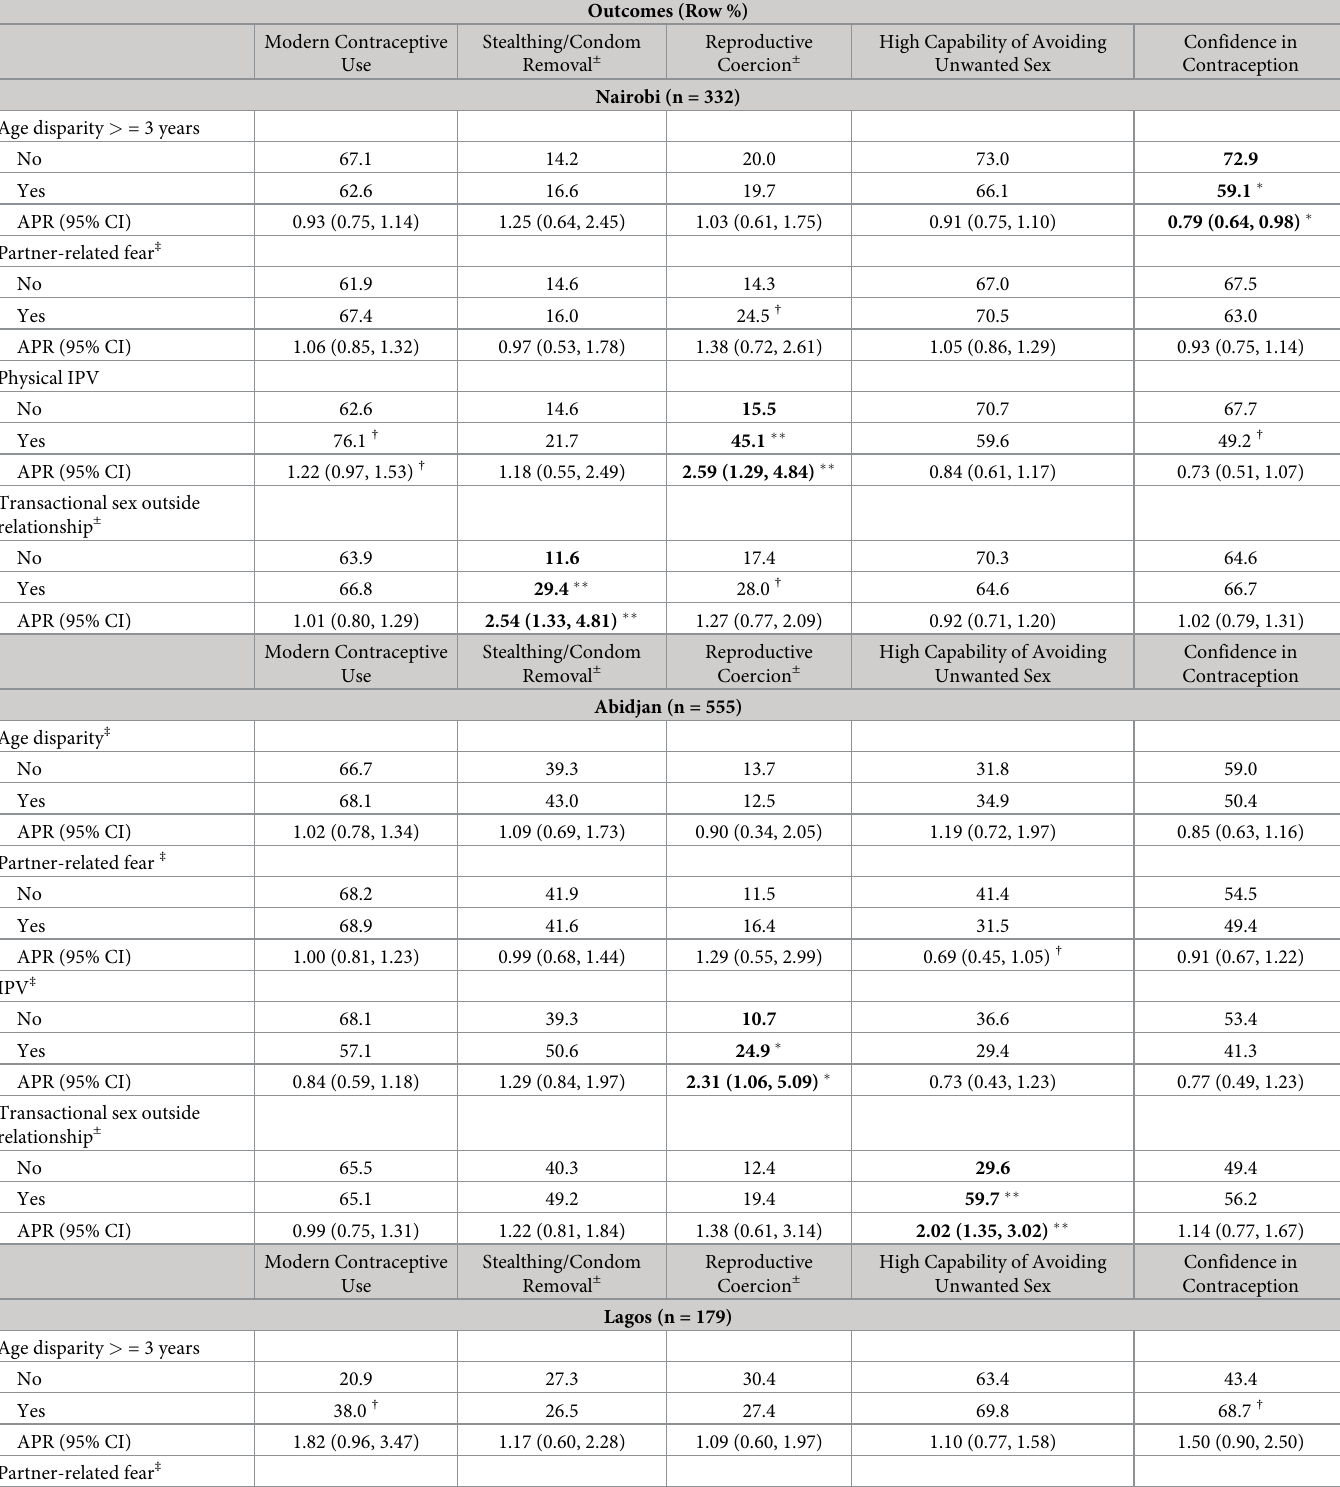
Table 3. Associations between relationship power disparities, contraceptive use, and threats to reproductive autonomy among currently-partnered AGYW by site, weighted.